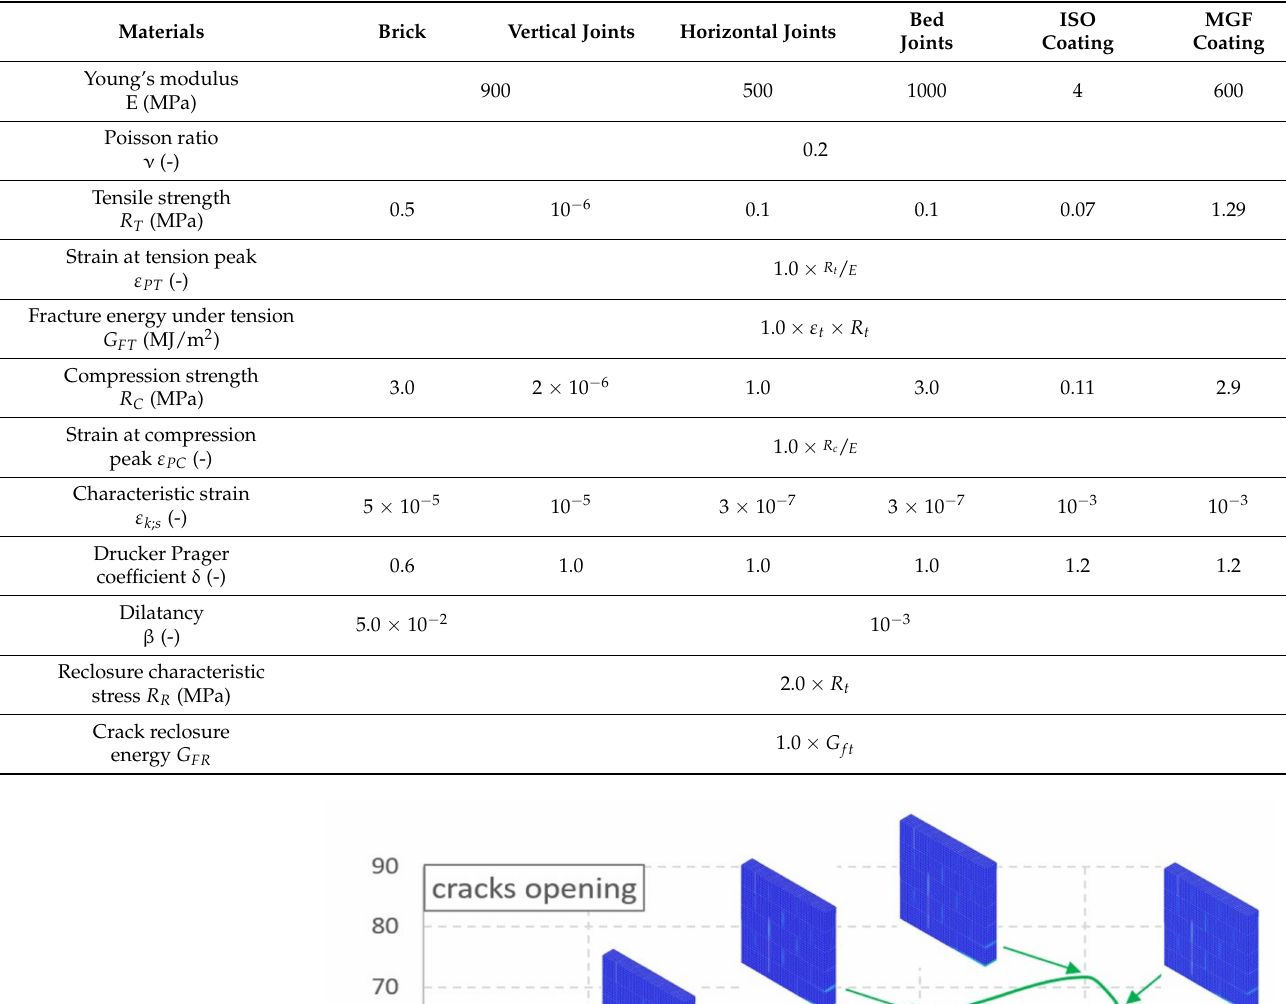
Table 3. Parameters set for the masonry and the coatings.